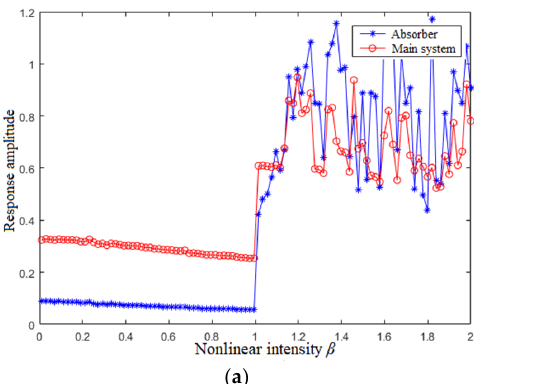
Figure 14. Response amplitude of two vibrators and phase diagram of main system in the case of resonance ω = 1.0. ( a ) Response amplitude; ( b ) Phase diagram ( β = 0.7).